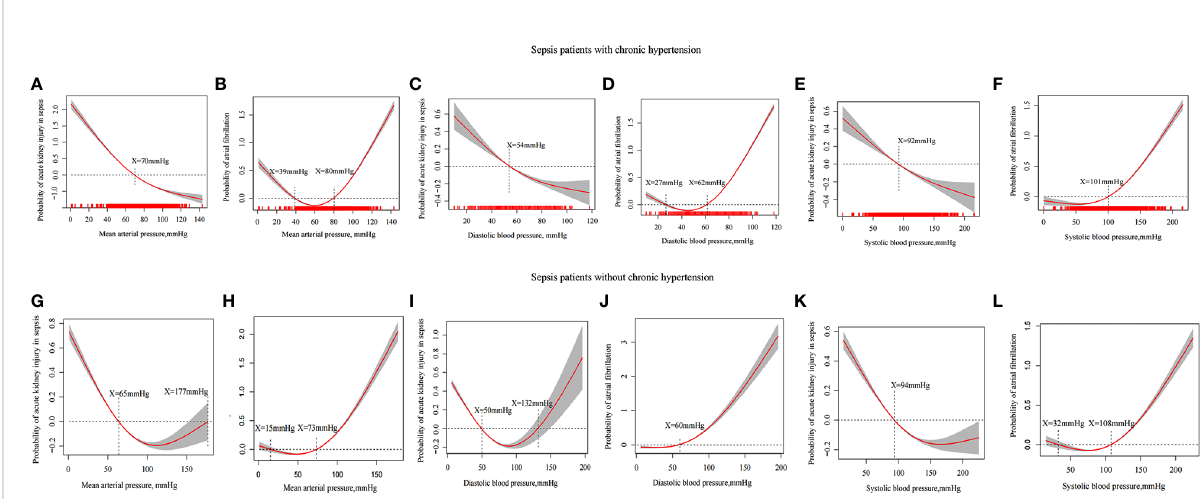
FIGURE 3 Generalized additive model evaluates the relationship between MAP, DBP, SBP and incidence in sepsis patients with AKI and incidence of atrial fi brillation. The relationship between MAP (A) , DBP (C) and SBP (E) and the incidence of AKI in sepsis patients with hypertension. The relationship between MAP (G) , DBP (I) and SBP (K) and the incidence of AKI in sepsis patients without hypertension. The relationship between MAP (B) , DBP (D) and SBP (F) and the incidence of atrial fi brillation in sepsis patients with chronic hypertension. The relationship between MAP (H) , DBP (J) and SBP (L) and the incidence of atrial fi brillation in sepsis patients with chronic